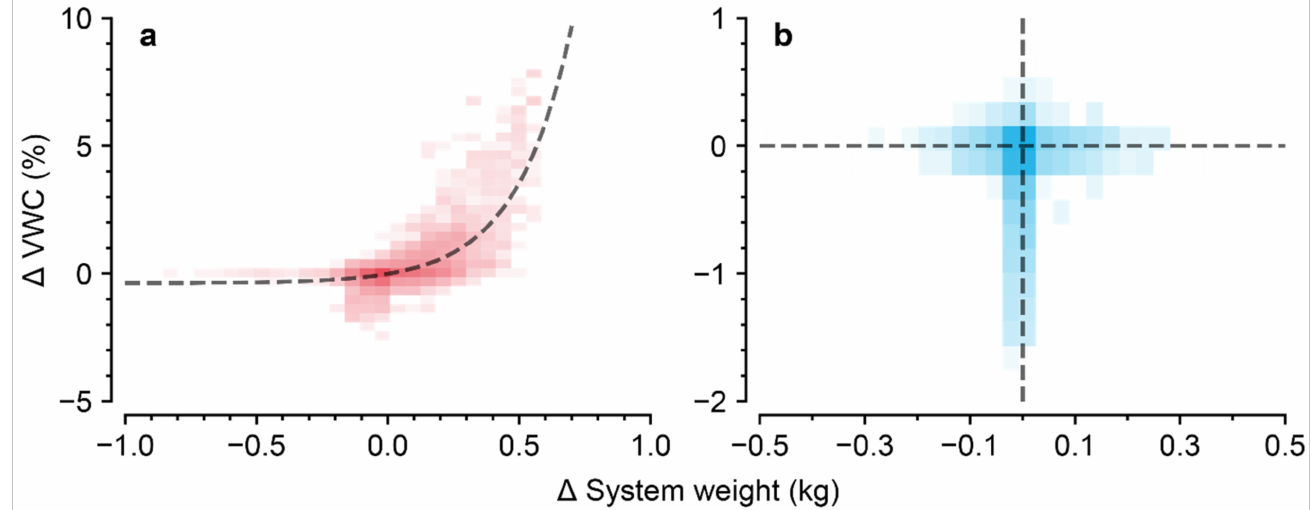
Figure 3. Relationship between total weight change and volumetric water content (VWC) change during ( a ) the daytime and ( b ) the nighttime. Averages of the total weight and VWC for every ten minutes, and the subtracted differences, are depicted.